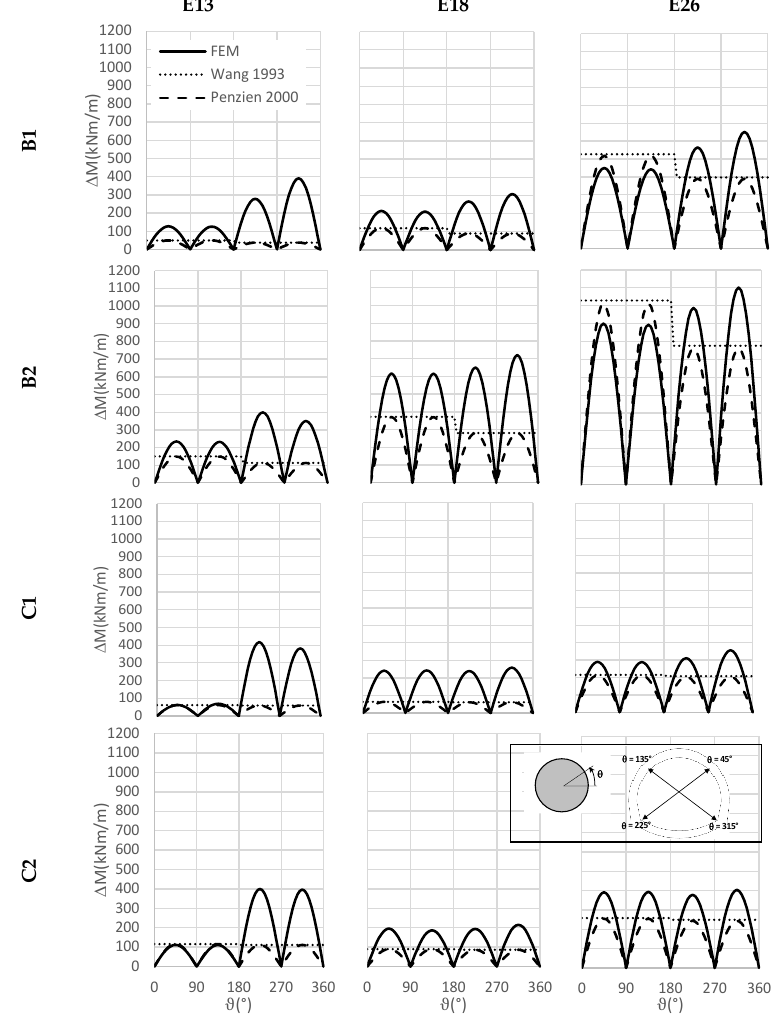
Figure 13. Comparison between numerical and analytical bending moments for the models B1, B2, C1, and C2.